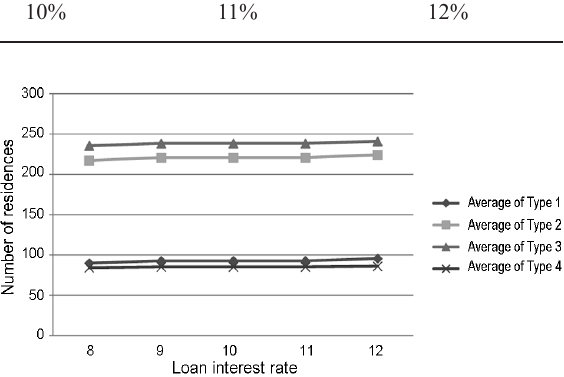
Fig. 4. Number of residences of the investment project depending on k